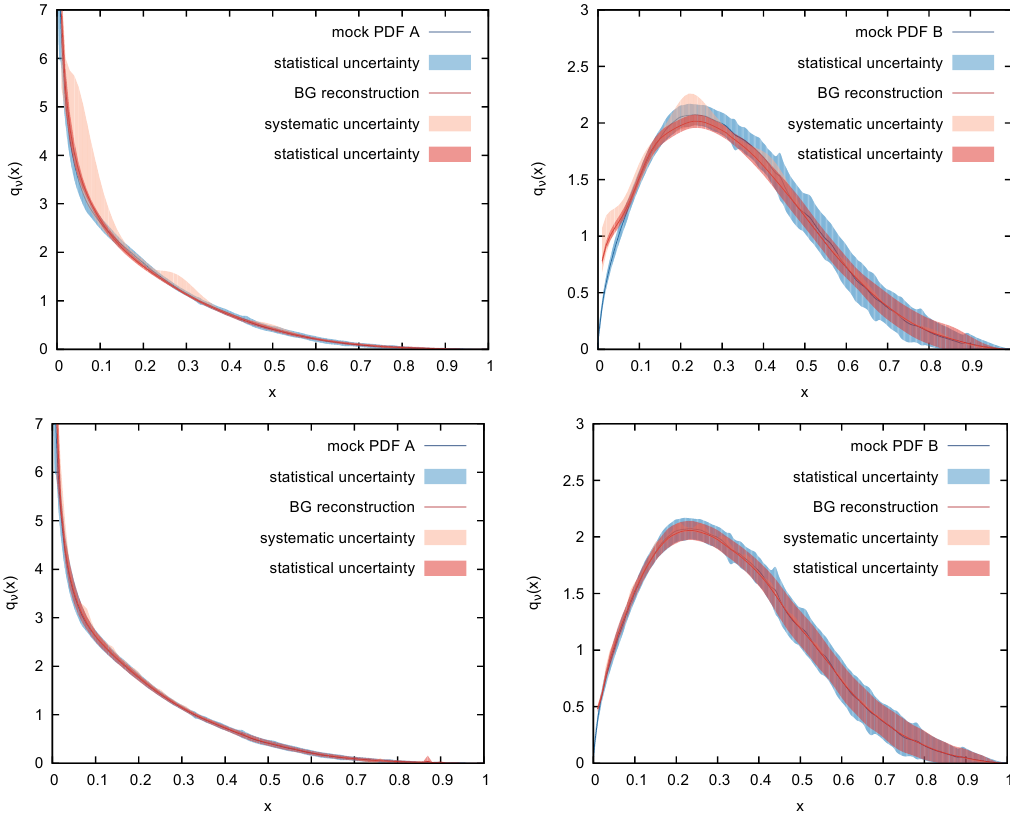
0.1 0.2 0.3 0.4 0.5 0.6 0.7 0.8 0.9